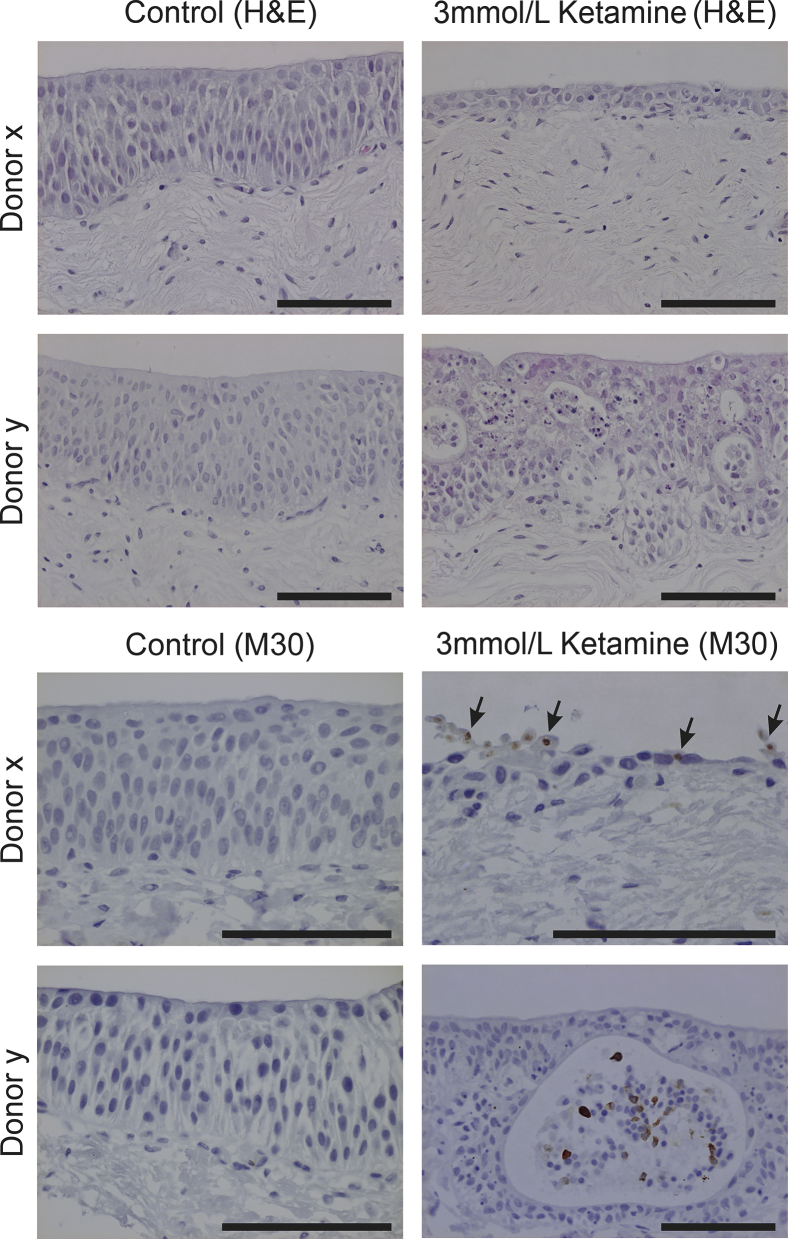
Histological assessment of human ureteric organ cultures after 72 hours' exposure to 3 mmol/L ketamine showed thinning of the epithelium (shown in the images of donor x) and clear signs of apoptosis, including pyknotic nuclei and karyorrhexis (shown in the images of donor y). Immunoreactivity with a cleaved cytokeratin 18 antibody (M30 Cytodeath) was observed in cells being lost from the epithelium (arrows). n = 6 donors with two representative examples shown. Scale bar = 100 μm. H&E, hematoxylin and eosin.